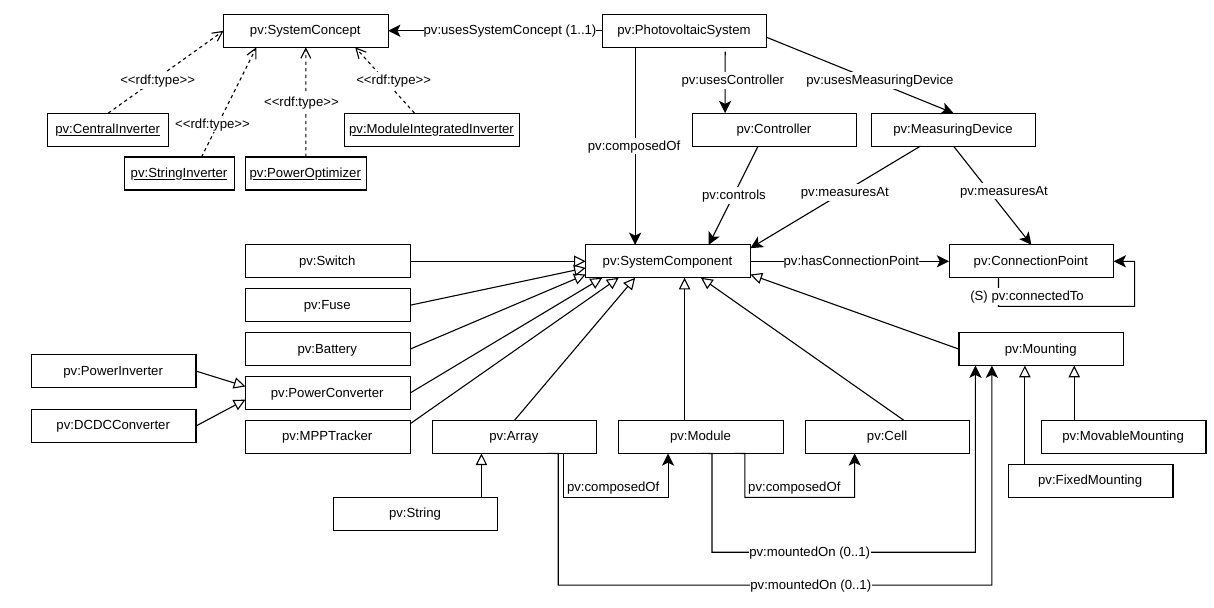
Figure 3. Overview of the